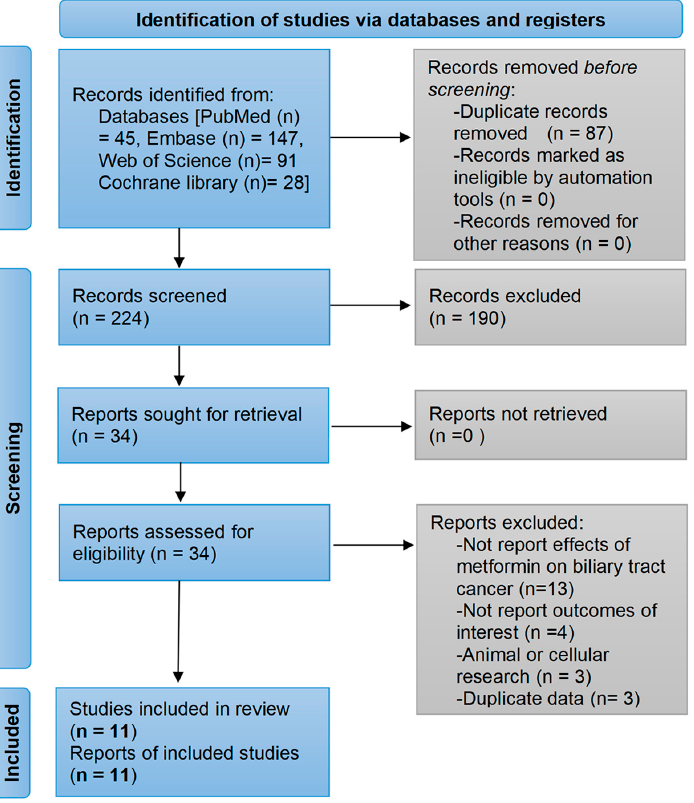
Figure 1. Flow diagram of the study selection process. The search strategies yielded a total of 311 papers of which, 11 studies were finally included based on eligibility criteria.